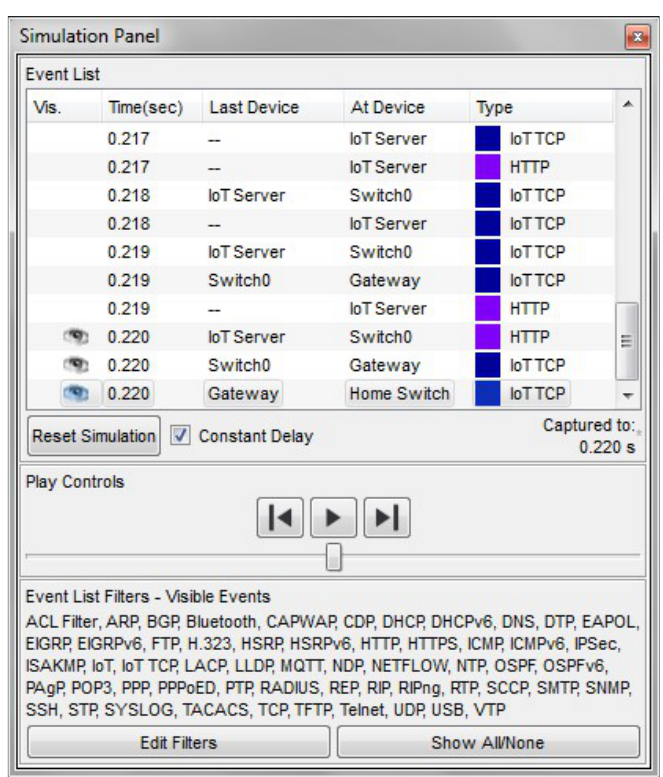
Figure 13. Packet capture for IoT communication with